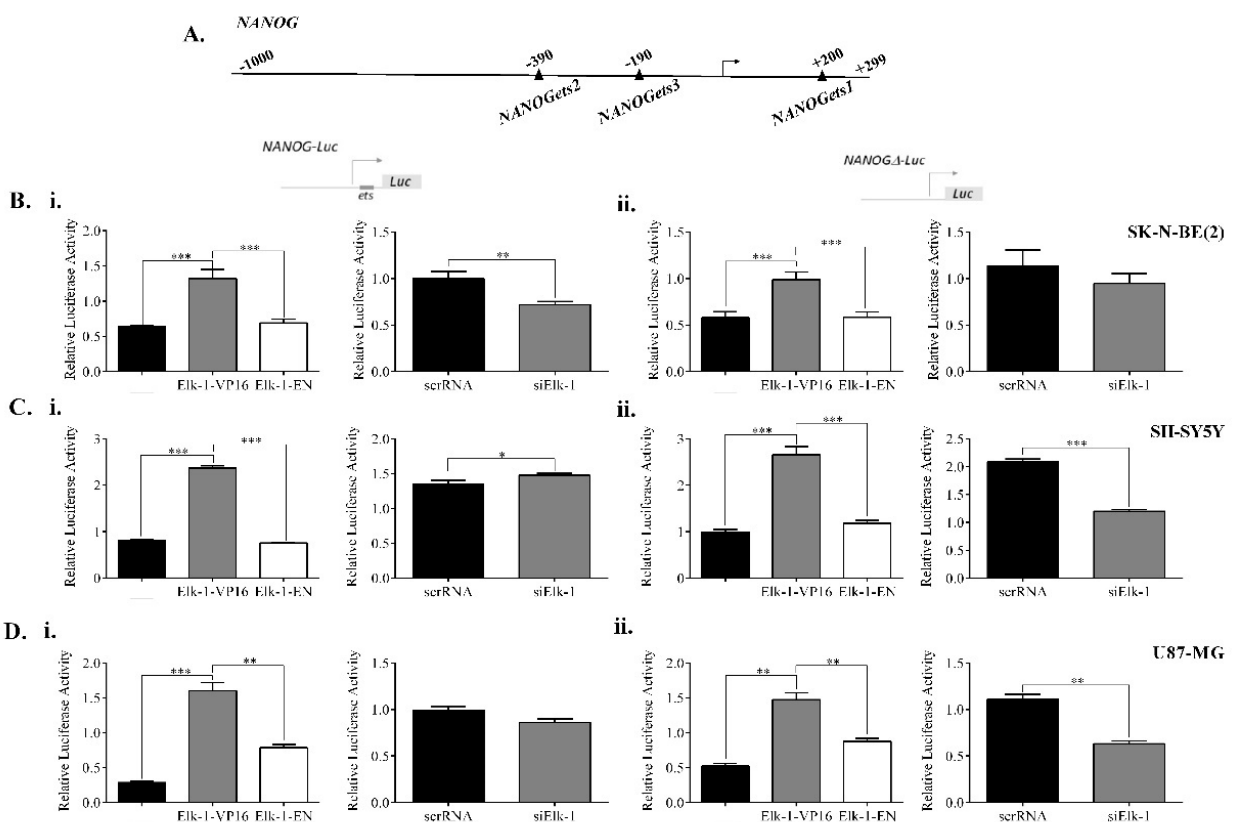
Figure 6. Regulation of NANOG promoter by Elk-1. ( A ) Schematic diagram of predicted ets motifs ets1-3 on NANOG promoter. Ets1 was predicted to be a stronger binding motif for Elk-1 and was deleted to generate NANOG ∆ - Luc reporter plasmid. ( B ) Luciferase assay for ( i ) wildtype NANOG -Luc and ( ii ) NANOG ∆ -Luc reporters in SK-N-BE (2) cells after transfection of expression plasmids with Elk1-VP16, Elk1-EN, or empty control plasmid pCDNA3.1 ( left graphs ) or co-transfection of silencing plasmids for scrRNA control or siElk-1 ( right graphs ). Luminometric measurements were normalized to Renilla-luc activity. ANOVA, Tukey’s multiple comparative tests, *** p < 0.001 for ( i ) and ( ii ) left graphs; unpaired two-tailed t-test, ** p < 0.01 was done for ( i ) and ( ii ) right graphs. ( C ) Luciferase assay for ( i ) wildtype NANOG -Luc and ( ii ) NANOG ∆ -Luc reporters in SH-SY5Y cells after transfection of expression plasmids with Elk1-VP16, Elk1-EN or empty control plasmid pCDNA3.1 ( left graphs ) or co-transfection of silencing plasmids for scrRNA control or siElk-1 ( right graphs ). Luminometric measurements were normalized to Renilla -luc activity. ANOVA, Tukey’s multiple comparative tests, *** p < 0.001 for ( i ) and ( ii ) left graphs; unpaired two-tailed t-test; * p < 0.5, *** p < 0.001 for ( i ) and ( ii ) right graphs. ( D ) Luciferase assay for ( i ) wildtype NANOG -Luc and ( ii ) NANOG ∆ -Luc reporters in U87-MG cells after transfection of expression plasmids with Elk1-VP16, Elk1-EN, or empty control plasmid pCDNA3.1 ( left graphs ) or co-transfection of silencing plasmids for scrRNA control or siElk-1 ( right graphs ). Luminometric measurements were normalized to Renilla -luc activity. ANOVA, Tukey’s multiple comparative tests, ** p < 0.01, *** p < 0.001 for ( i ) and ( ii ) left graphs; unpaired t -test; ** p < 0.01 for ( i ) and ( ii ) right graphs.